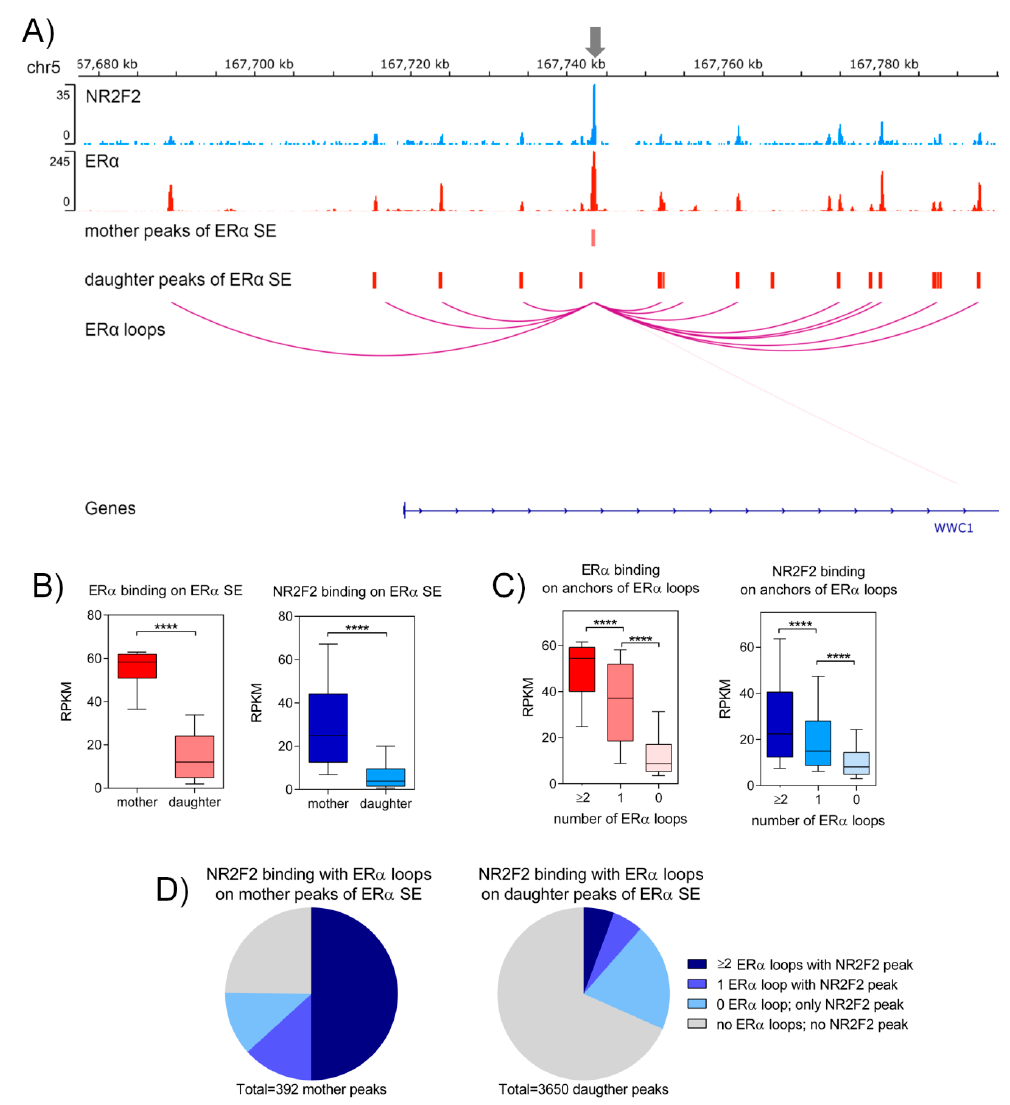
Figure 4. NR2F2 binds to mother regions of ER α super-enhancers (SE) in MCF-7 breast cancer cells. ( A ) IGV screenshot shows that NR2F2 and ER α binding sites marked the mother and daughter regions of ER α SE with ER α bound chromatin interactions at WWC1 gene. ( B ) Box plots show the ER α and NR2F2 binding intensities on mother and daughter regions of ER α SE. Mann-Whitney test, **** significant at p < 0.0001. ( C ) Box plots show the ER α and NR2F2 binding intensities on anchor regions of ER α bound chromatin interactions based on number of interactions. Mann-Whitney test, **** significant at p < 0.0001. ( D ) Pie charts represent the percentage of mother (left) or daughter (right) regions of ER α SE overlapping with NR2F2 binding sites associated to ER α bound chromatin interactions.